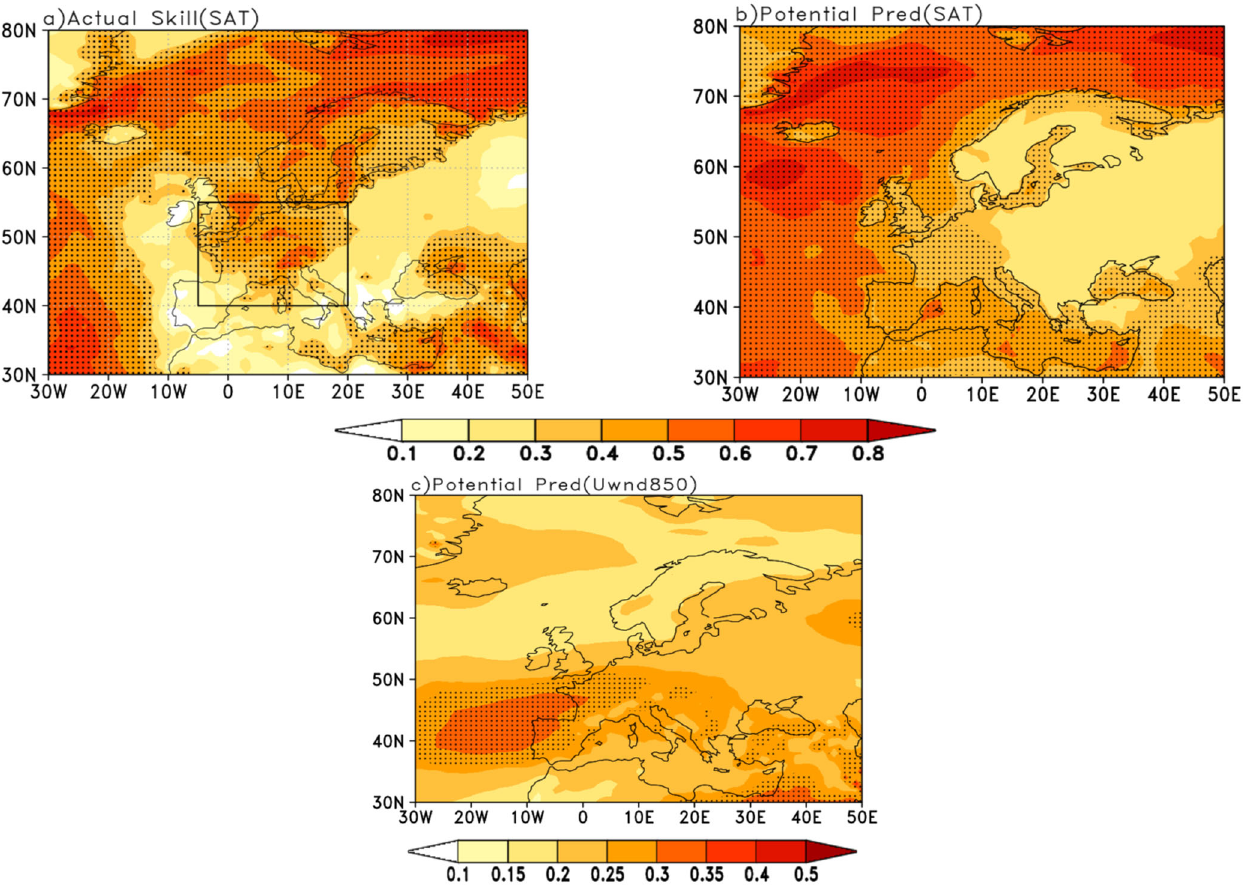
Fig. 8 Prediction skill of the temperature and winds in the North Atlantic European region. a Actual prediction skill of the early winter (November – December; ND) Surface Air Temperature (SAT) anomalies over the North Atlantic European (NAE) region for the period 1981 – 2019; ( b ) Potential Predictability of the SAT over the NAE region for the same period. Stippling denotes statistical signi fi cance at 95% con fi dence level. The Prediction skill of the SAT over the western European region [0:20 °E; 45:55 °N] is 0.52. c Same as of ( b ) but for 850-hPa zonal winds (Uwnd850) anomalies. Stippling denotes statistical signi fi cance at 90% con fi dence